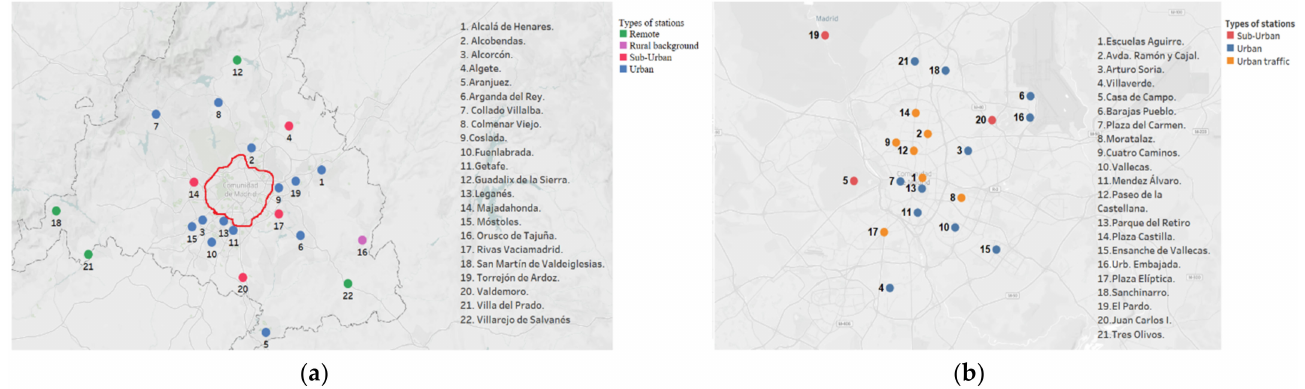
Figure 1. Distribution of air quality monitoring stations. ( a ) CM, ( b ) Madrid city